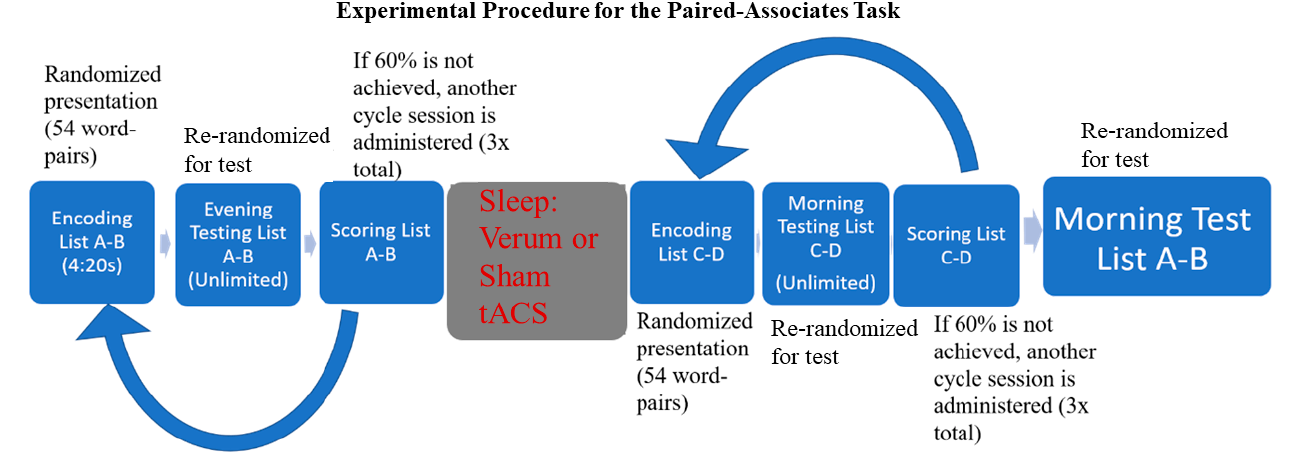
Figure 1. Experimental timeline for retroactive interference paired-associates task (ri-PAT)